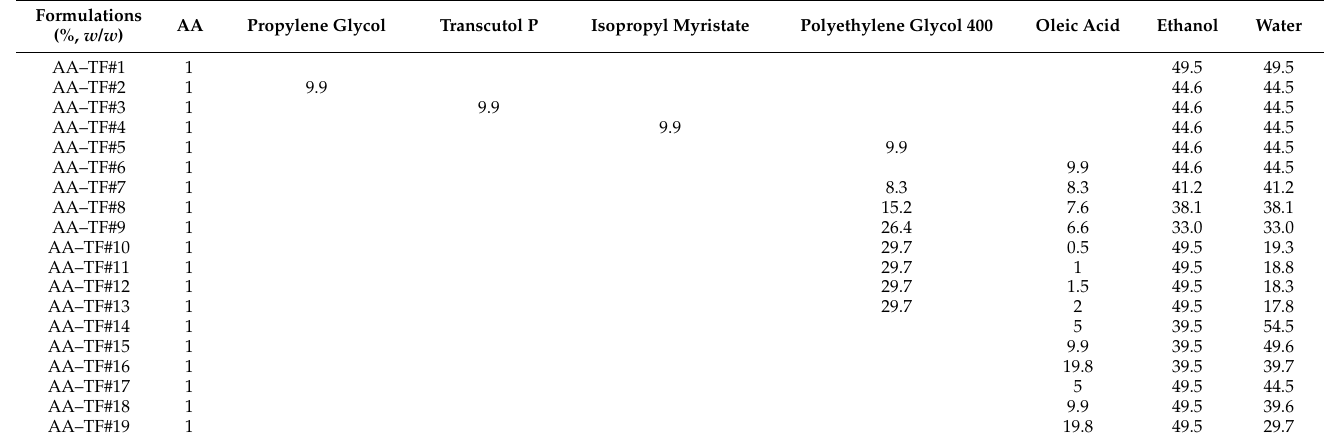
Table 1. Compositions of AA-loaded topical